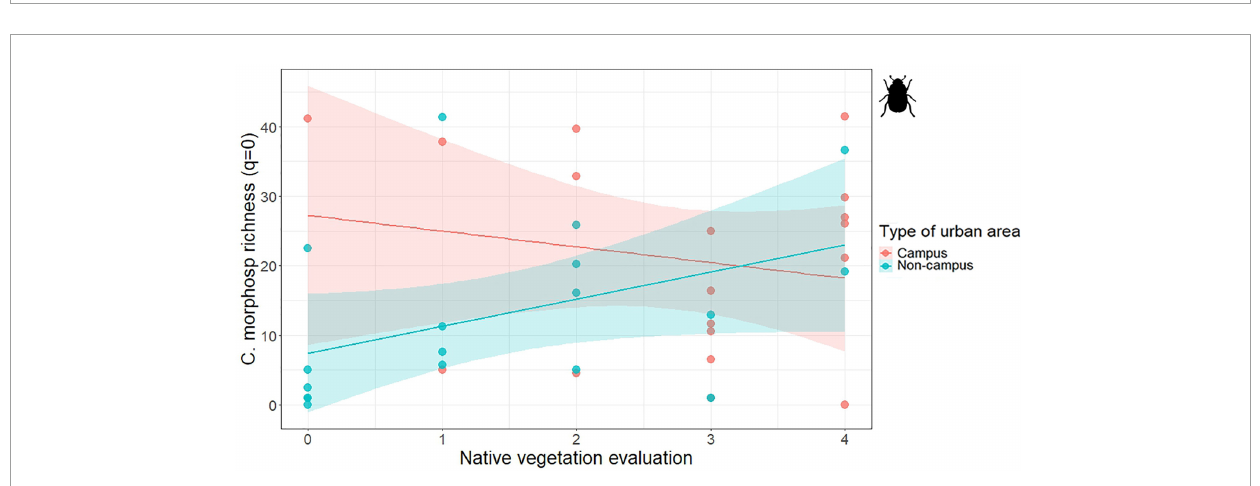
FIGURE3 Association between the ground-dwelling Coleoptera morphospecies richness ( q = 0) and the native vegetation in combination with the type of urban area. Colored bands represent confidence intervals.